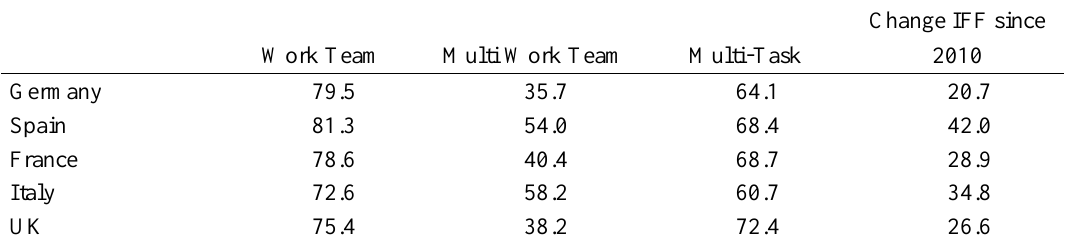
Table 2 . Percentage of establishment that use IFF by type, country, and change in IFF since